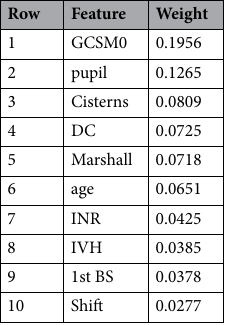
Table 3. Feature weights calculated by information gain applied on 5-classes-dataset of gos0. GCSM0: motor component of GCS on admission, DC: decompressive craniotomy, INR: international normalized ratio, IVH: intraventricular hemorrhage, BS: blood sugar.